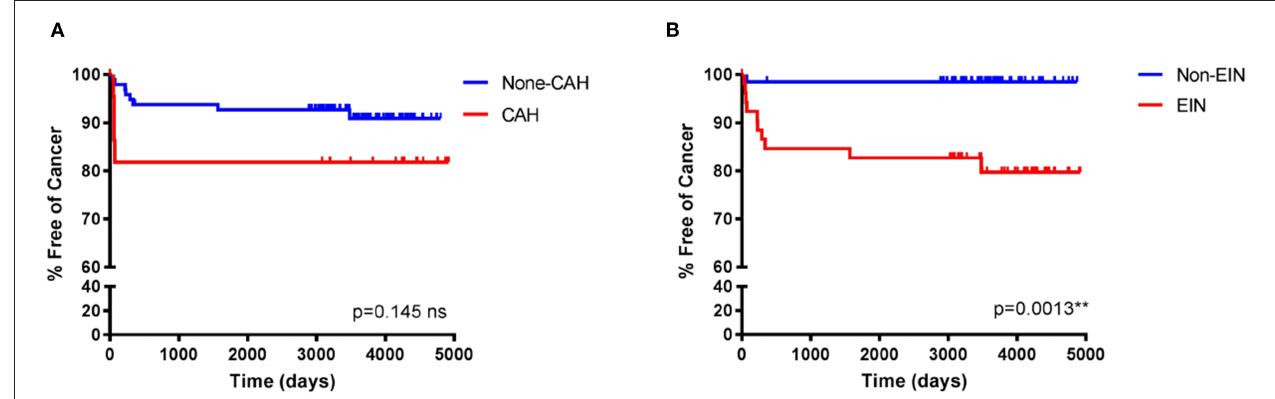
FIGURE 2 | Kaplan–Meier curves to demonstrate the percentage of endometrial hyperplasia patients free of cancer during follow-up when classified using the WHO94 compared with the EIN/WHO2014 classification systems. Median follow-up period (mean, SD) 3,485 days (3,180, 1,383 days). (A) The original diagnostic classification of the patients in this study utilized WHO94 criteria. Percentage cancer-free time was not statistically significantly different between those with a WHO94 diagnosis of CAH vs those with a non-CAH diagnosis, Log-Rank (Mantel-Cox) 2.115, p = 0.145 ns, HR 3.029 (95% CI 0.68–13.49). (B) Consensus reclassification of the same EH cohort of patients utilizing EIN/WHO2014, revealed a statistically significant difference in the percentage cancer-free time between those reclassified to an EIN diagnosis vs those reclassified to a non-EIN diagnosis, Log-Rank (Mantel-Cox) 10.41, p = 0.0013**, HR 13.37 (95% CI 4.05–44.13). NB/ = Non-CAH incorporates patients with CH ( n = 29), SH ( n = 51), and HP ( n = 15). EIN incorporates EIN ( n = 49) and EIN-EMP ( n = 3). Non-EIN incorporates patients with HwA ( n = 50) HP without EIN ( n = 6) and atrophic/benign endometrium ( n = 8).